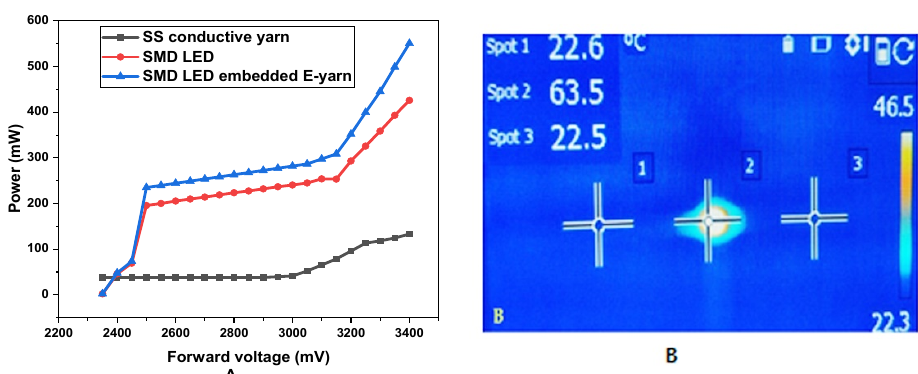
Figure 8. Power of SMD LED and E-yarn with a variable input voltage ( A ), IR thermographic image